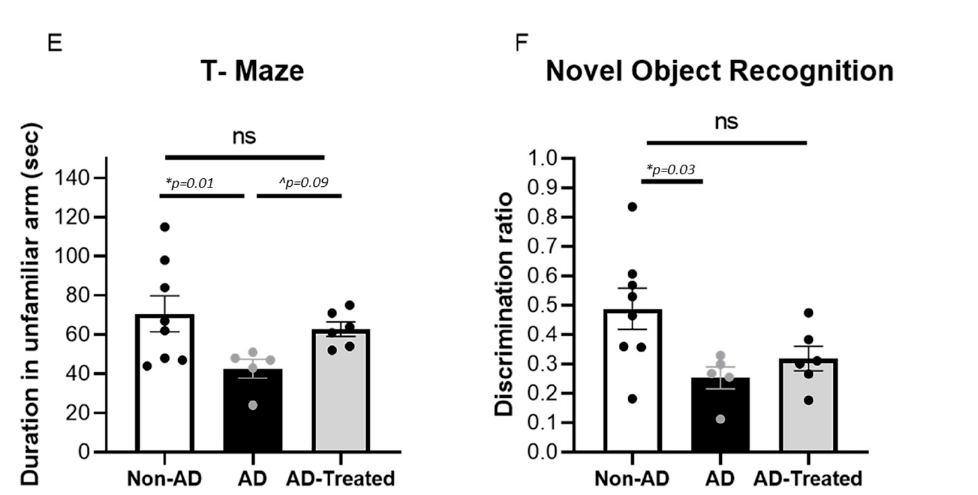
Figure 1. IV mitochondria-treated AD mice performed better in cognitive tests than untreated AD mice. ( A , B ) AD mice that received four injections of mitochondria starting at 6 months of age showed better cognitive performance compared to untreated mice, approaching the performance of non-AD mice. In the Open Field Habituation test ( A ), there was a significantly lower distance walk in Day 2 compared to Day 1 in the non-AD mice ( t -test, p < 0.001) and in the treated AD mice ( p < 0.001), but not in the untreated AD mice. In the Y-maze test ( B ), one-way ANOVA showed a trend toward difference between the groups [f(2, 16) = 3.22, p = 0.06]. LSD post-hoc analysis